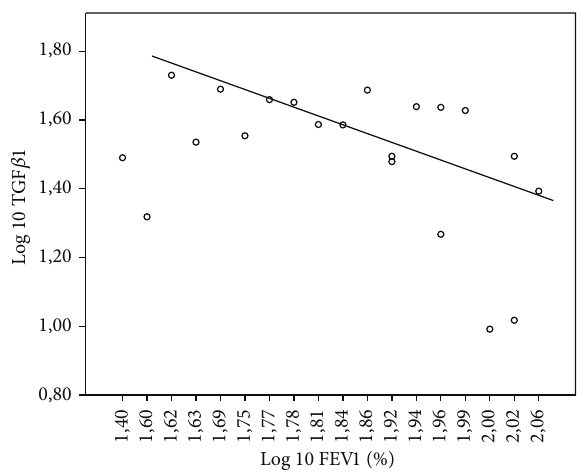
Figure 5: Log 10 TGF 𝛽 1 (pg/mL) in serum in CF patients plotted as a function of Log VC (%) with linear regression line ( 𝑟 = −0.572 , 𝑃 < 0.007 ).